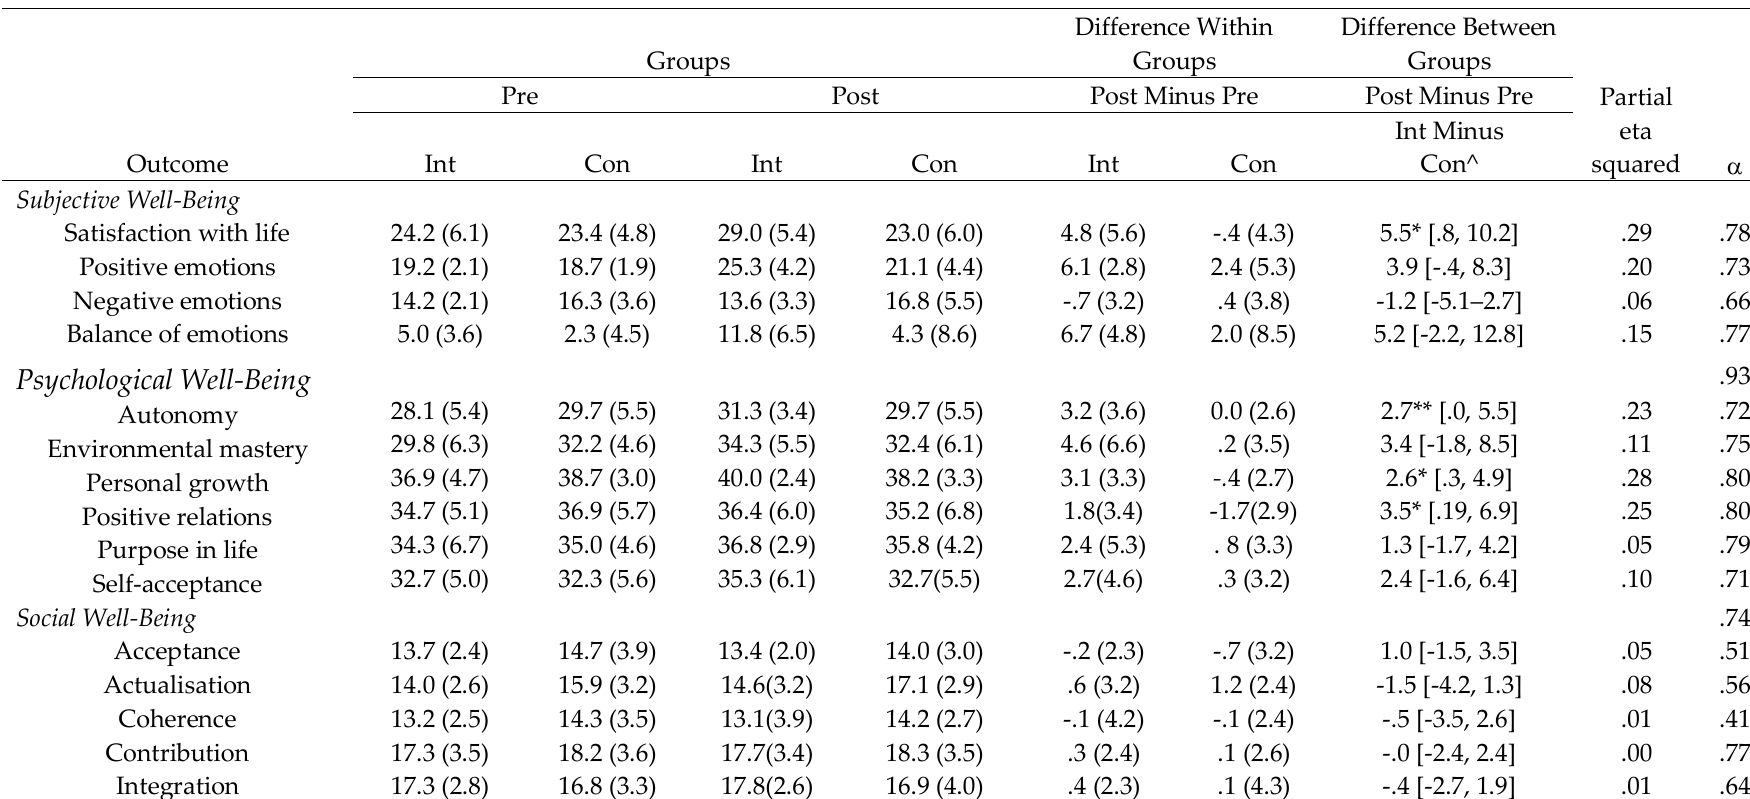
Table 3: Mean ( SD ) of Groups, Mean ( SD ) Difference Within and Between (i.e., Difference-in-Difference) Groups (95% CI), and Alpha Coefficients for Primary Hypothesis Outcomes